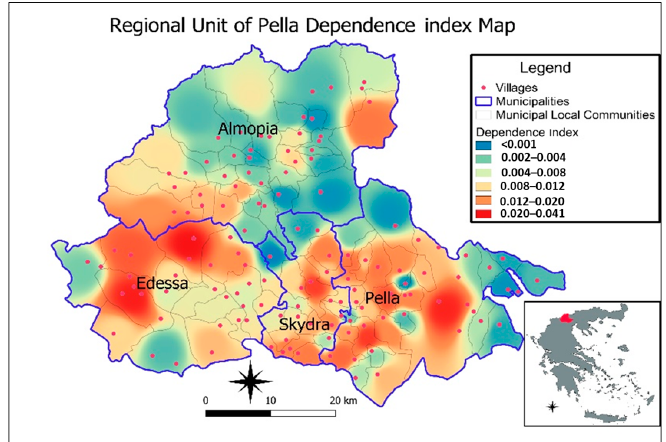
Figure 2. Relative Dependence Map (RDI) for year 2018.